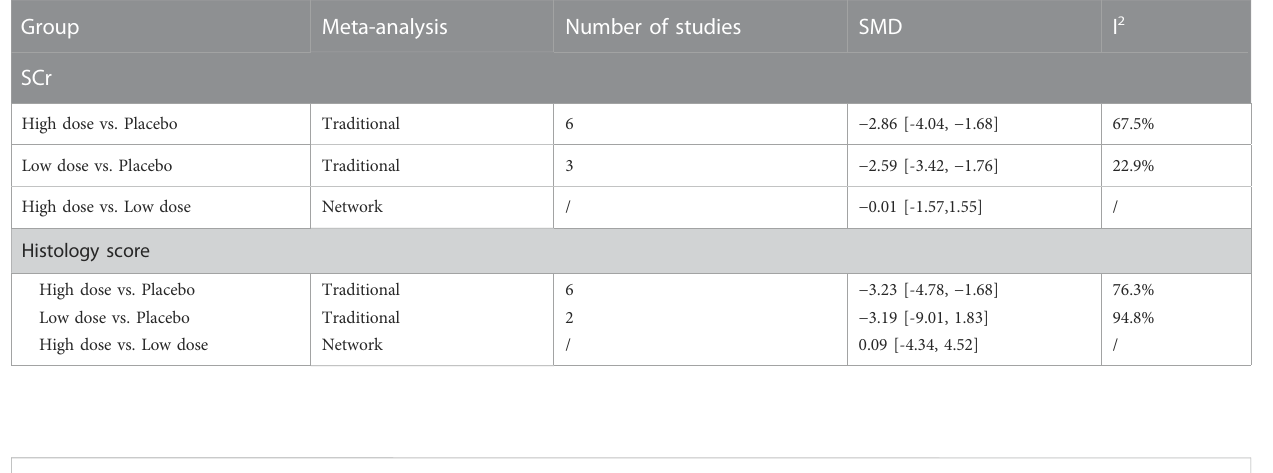
TABLE 5 Comparison of different doses in intrarenal transplantation group.